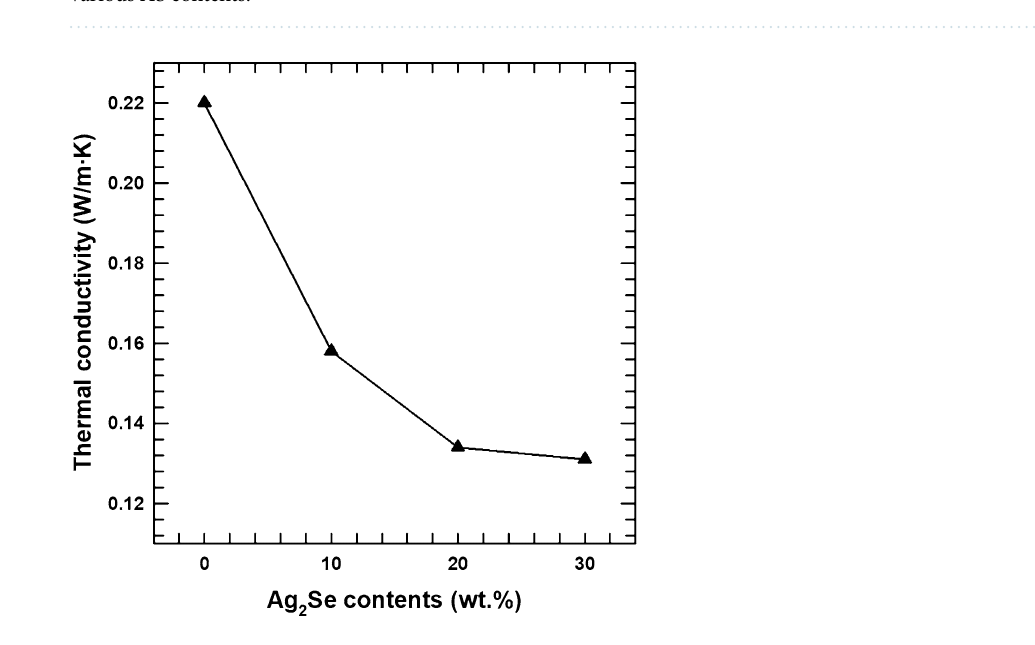
Figure 7. Thermal conductivity of composite sample with various AS